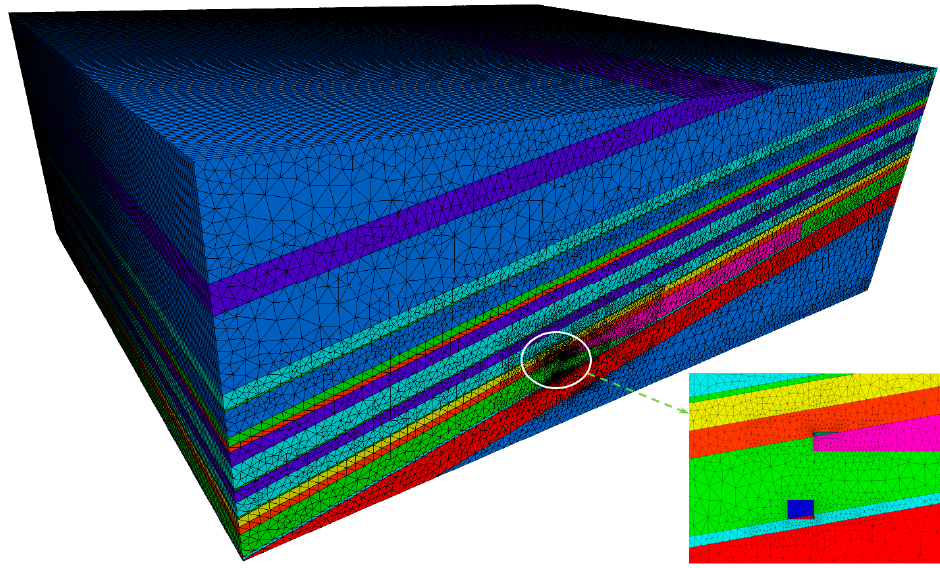
Figure 8. FLAC3D numerical model.